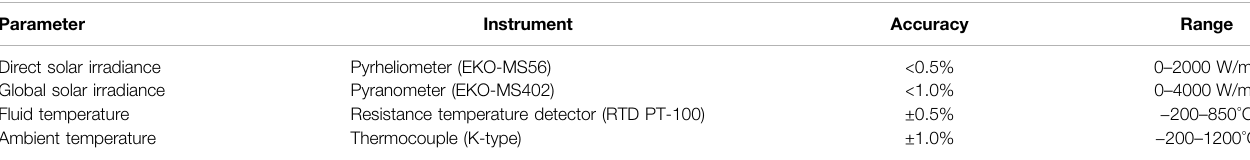
TABLE 3 | Parameters and speci fi cations of the respective measuring